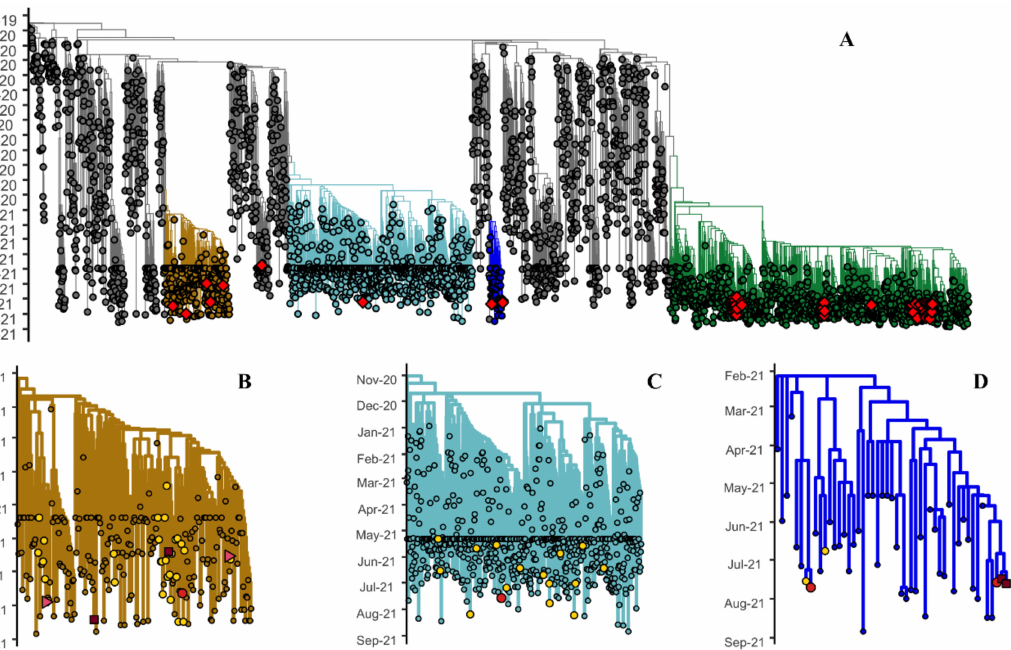
Figure 1. Phylogenetic relationship of SARS-CoV-2, 2019–2021. Global context tree highlighting the different variants: ( A ) Gamma (gold), Alpha (teal), Mu (blue), and Delta (green). Red diamonds indicate the viruses obtained in this study. The relationships of the different variants detected in the studied patients were magnified into ( B ) Gamma, ( C ) Alpha, and ( D ) Mu. Yellow circles indicate viruses isolated in Mexico. Red circles indicate ambulatory vaccinated patients. Red squares indicate hospitalized vaccinated patients. Pink triangles indicate hospitalized non-vaccinated patients. Sequences used in this analysis were downloaded from the Global Initiative for Sharing All Influenza Data (GISAID)